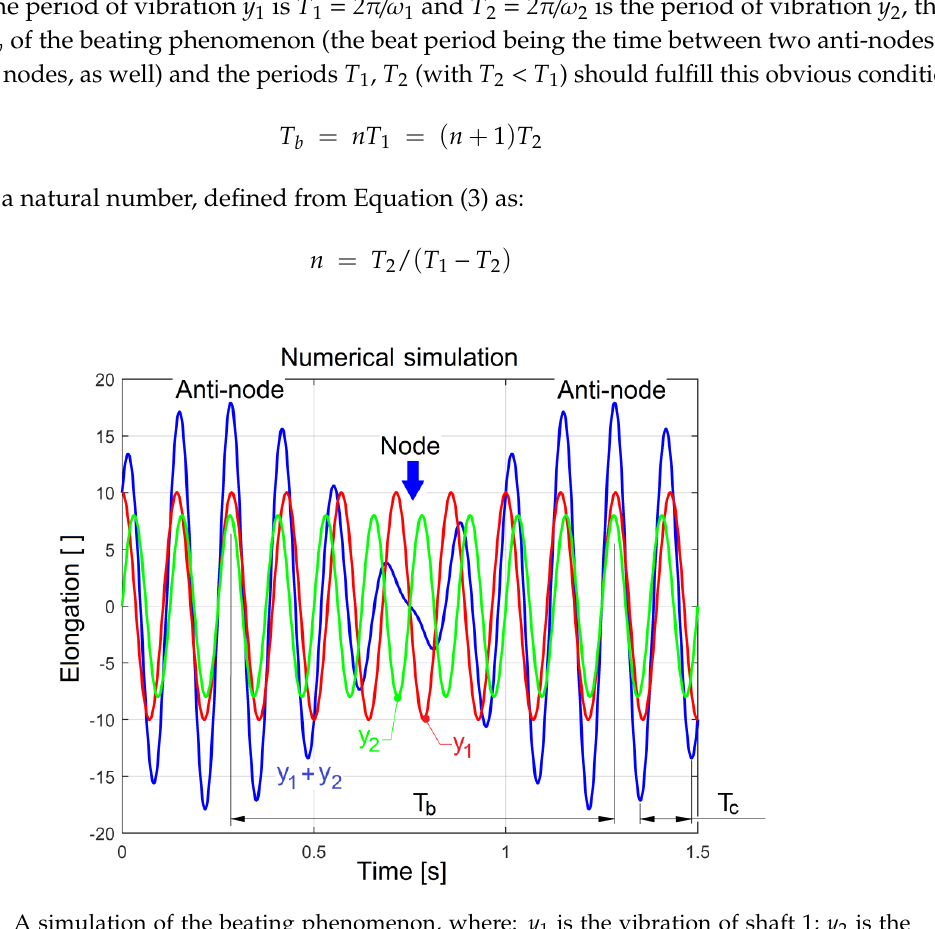
Figure 1. A simulation of the beating phenomenon, where: y 1 is the vibration of shaft 1; y 2 is the vibration of shaft 2, T b is the beat period; and T c is the period of the resultant vibration y 1 + y 2 .